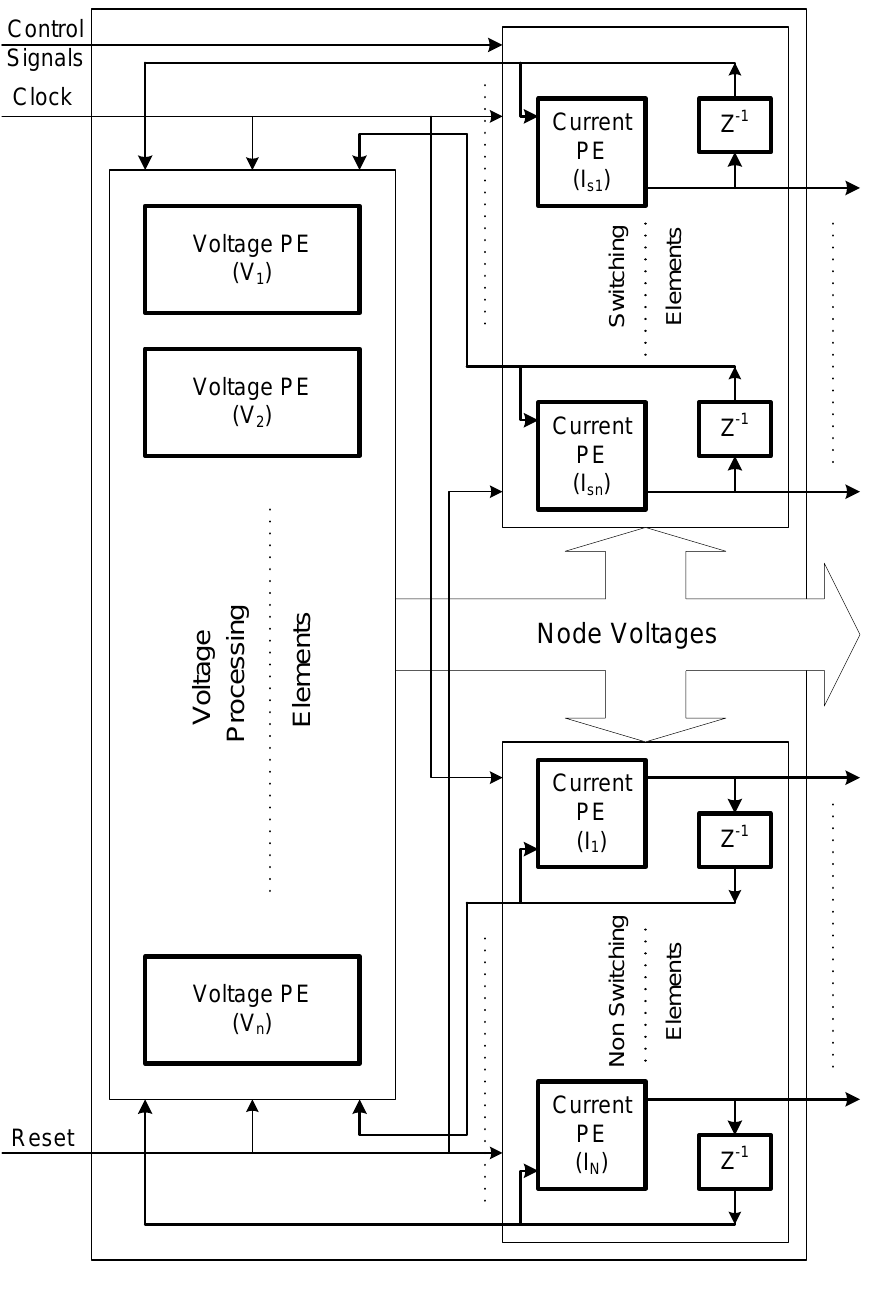
Figure 4. Functional diagram of the computational